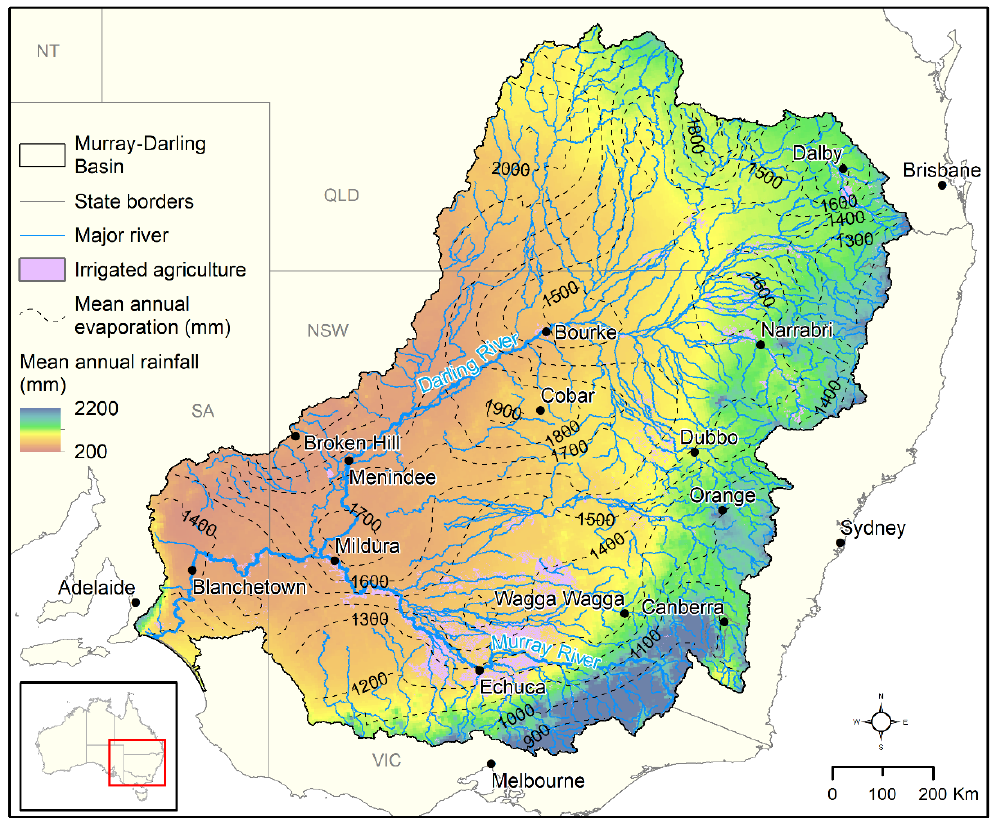
Figure 1. Murray–Darling Basin mean annual rainfall and evaporation, major rivers, and irrigated